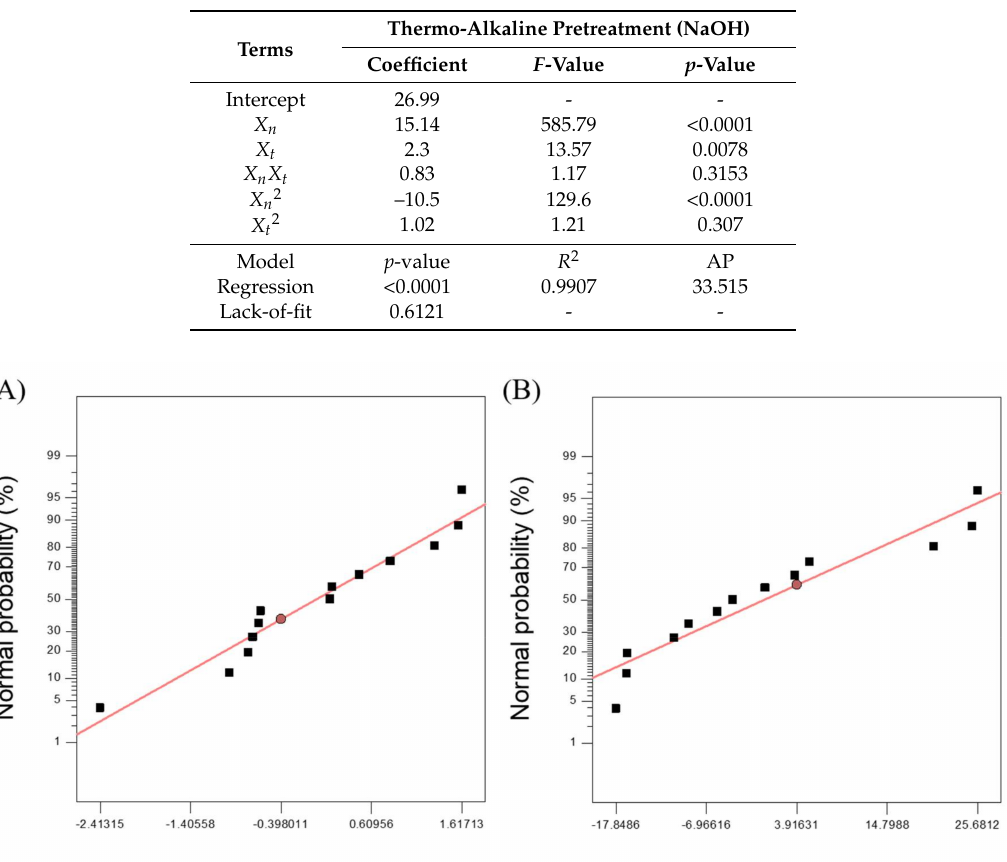
Table 4. Statistical significance of the model coefficients for predicting the response of the degree of solubilization (SD).